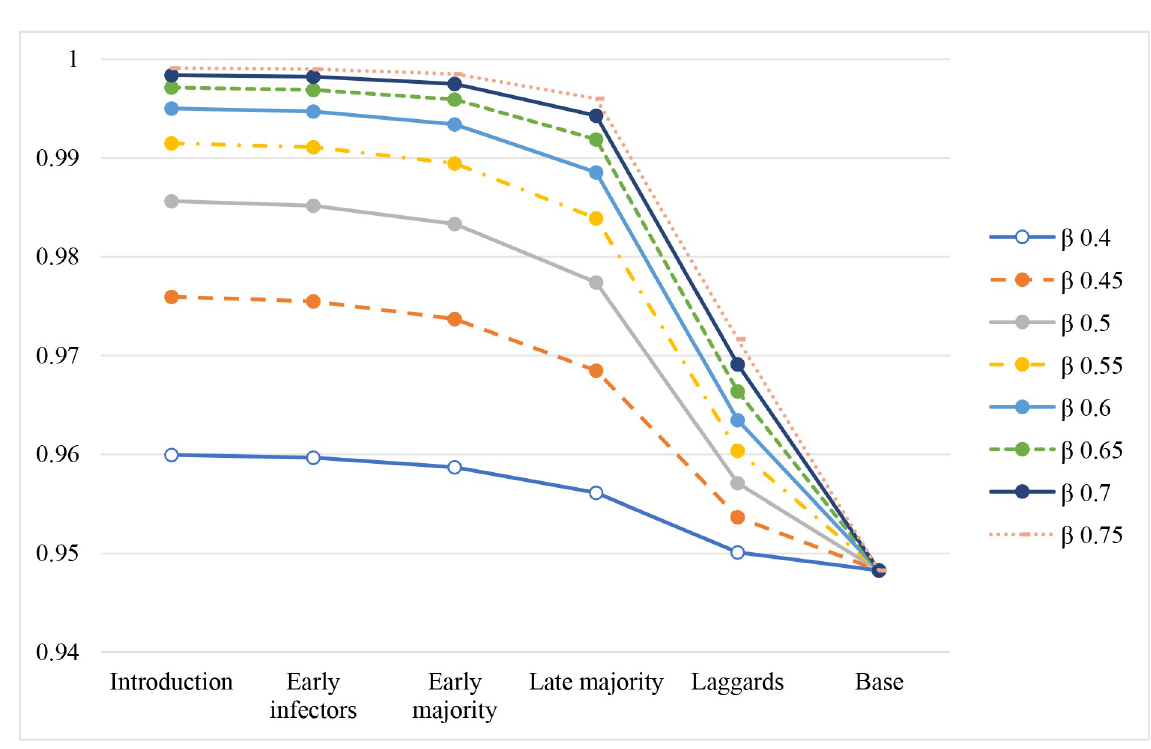
Fig 6. The cumulative infected (i.e., the recovered fractions or total infected) with different levels of reopening businesses. https://doi.org/10.1371/journal.pone.0280429.g006 PLOS ONE | https://doi.org/10.1371/journal.pone.0280429 January 26,